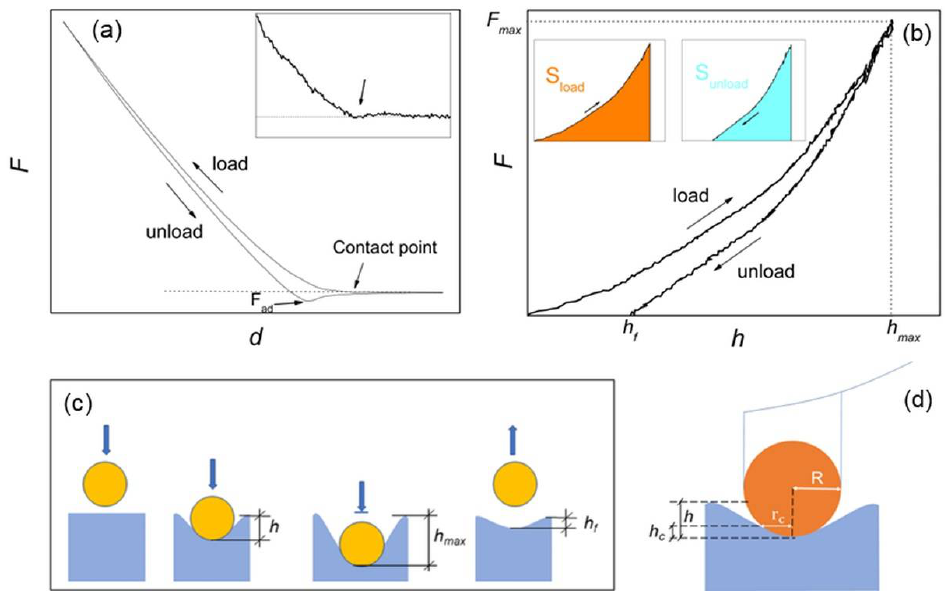
Figure 1. ( a ) force-displacement ( F-d ) curve with indication of the contact point (see also the inset) and adhesion force F ad ; ( b ) force-penetration depth ( F-h ) curve equivalent to F-d , with indication of the effective ( h f ) and maximum ( h max ) penetration depths and the maximum loading force F max . In the inset, the colors evidence the areas under the load (S load ) and unload (S unload ) curves, respectively; ( c ) schematic of the spherical indentation, with graphical indication of h , h f and h max ; and ( d ) compression by a rigid sphere of radius R , with indication of the contact radius r c and the contact depth h c .